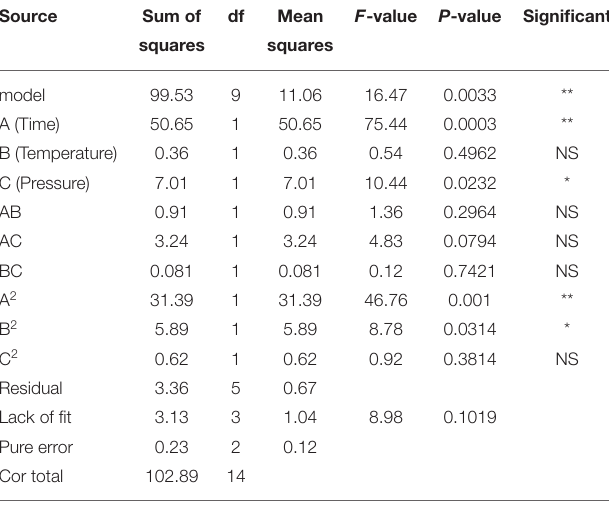
TABLE 2 | Extraction rate of Moringa seed oil by supercritical CO 2 with varying time, temperature, and pressure using response surface methodological